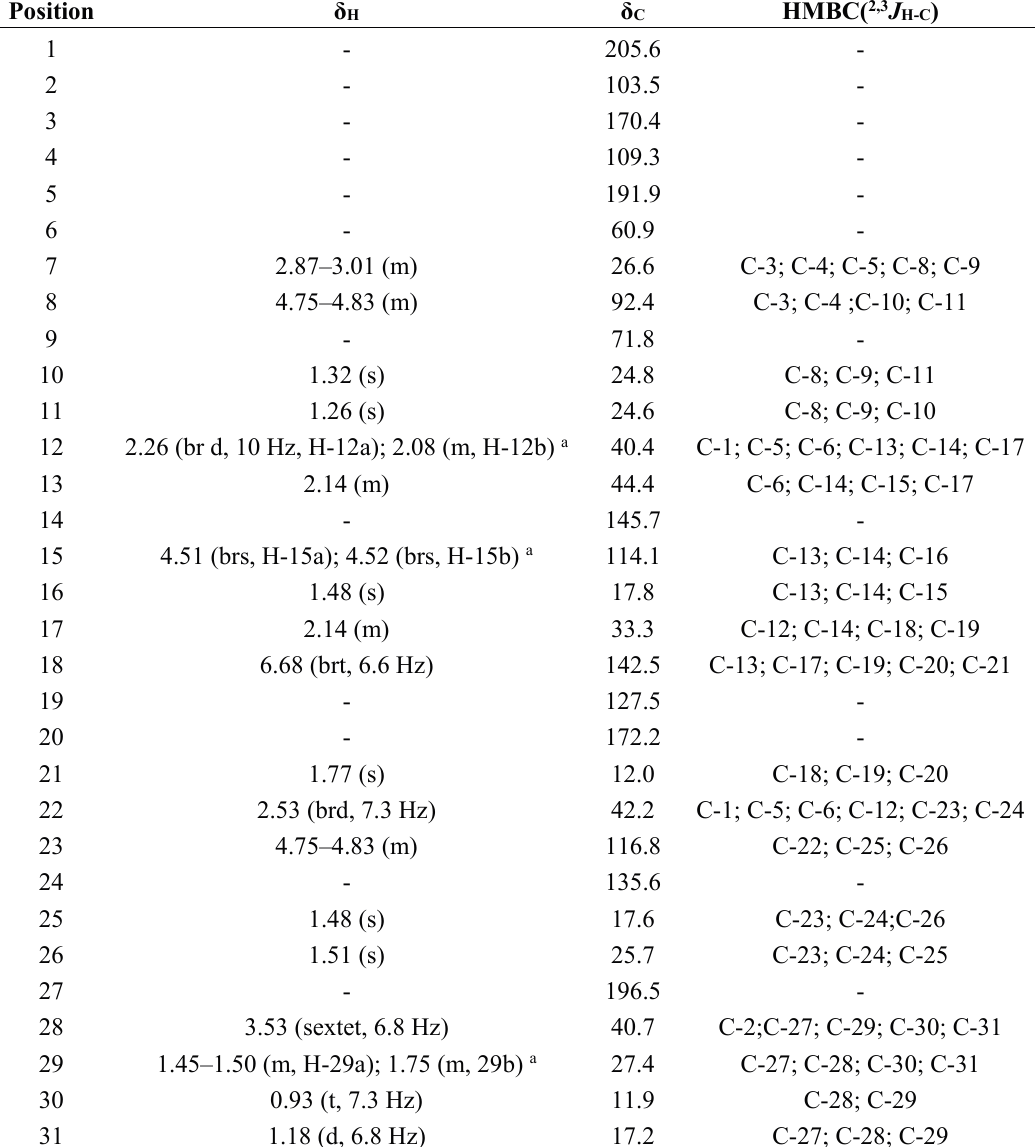
Table 1. 1 H (500 MHz) and 13 C (125 MHz) NMR data of 1 in CDCl 3